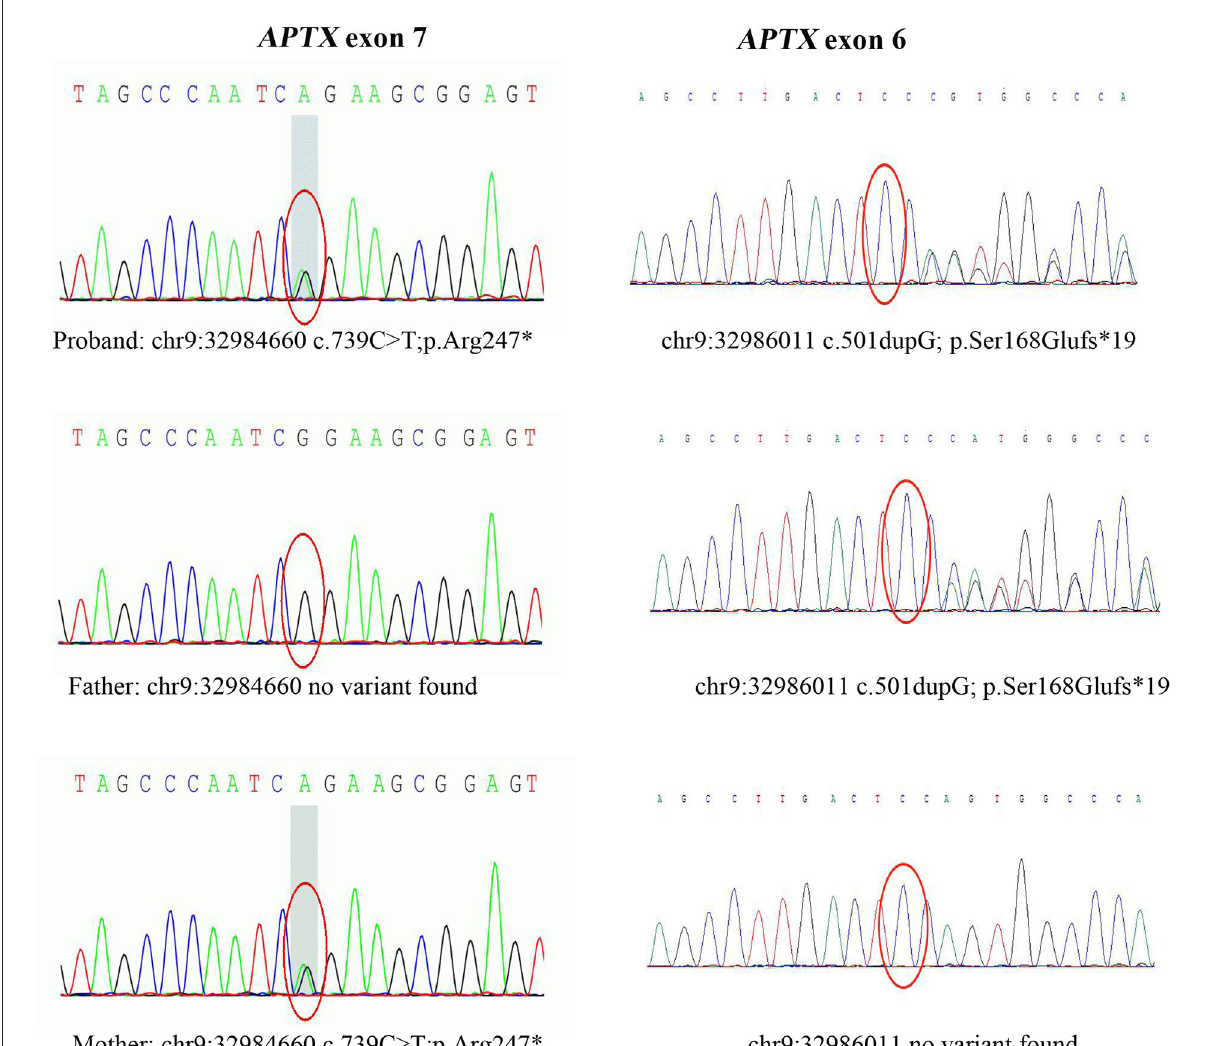
FIGURE3 Sanger sequencing of APTX exons. Sanger sequencing after PCR amplification revealed compound heterozygous mutations: the nonsense mutation (c.739C > T, p.Arg247*) in exon 7, and a frameshift mutation (c.501dupG, p.Ser168Glufs*19) in exon 6. c.501dupG is novel, while c.739C > T is a known pathogenic